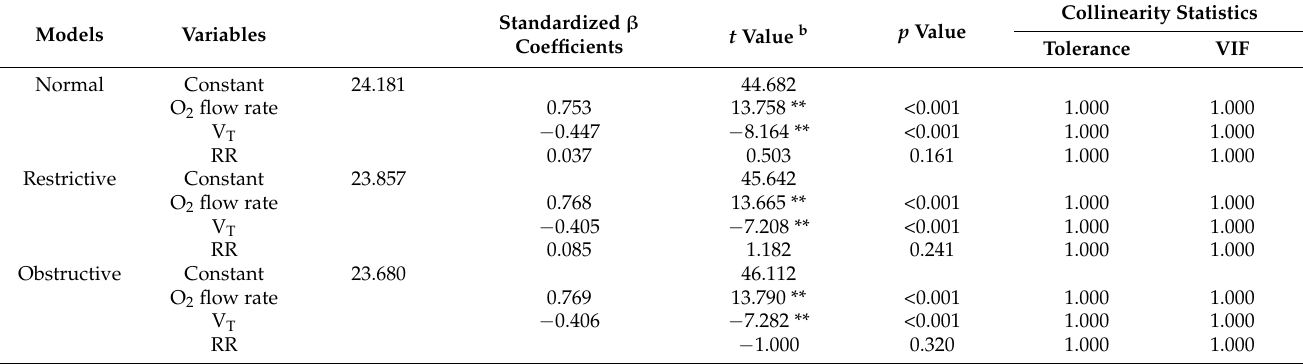
Table 1. Multiple Linear Regression Analysis Predicting the measured FiO 2